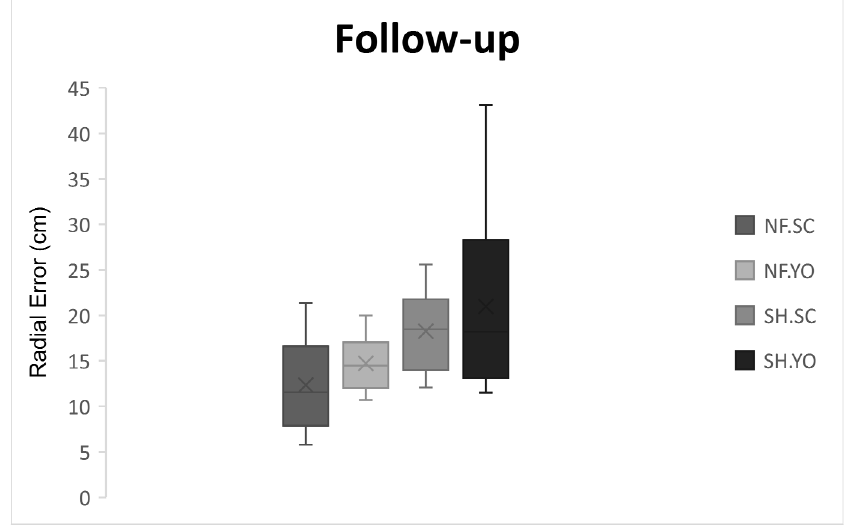
Figure 5. Boxplot of golf putting accuracy during pretest, post-test, and follow-up. Crosses in each box represent the mean. NF.SC: neurofeedback/self-controlled practice; NF. YO: neurofeedback/yoked practice; SH.SC: sham/self-controlled practice; SH. YO: sham/yoked practice.